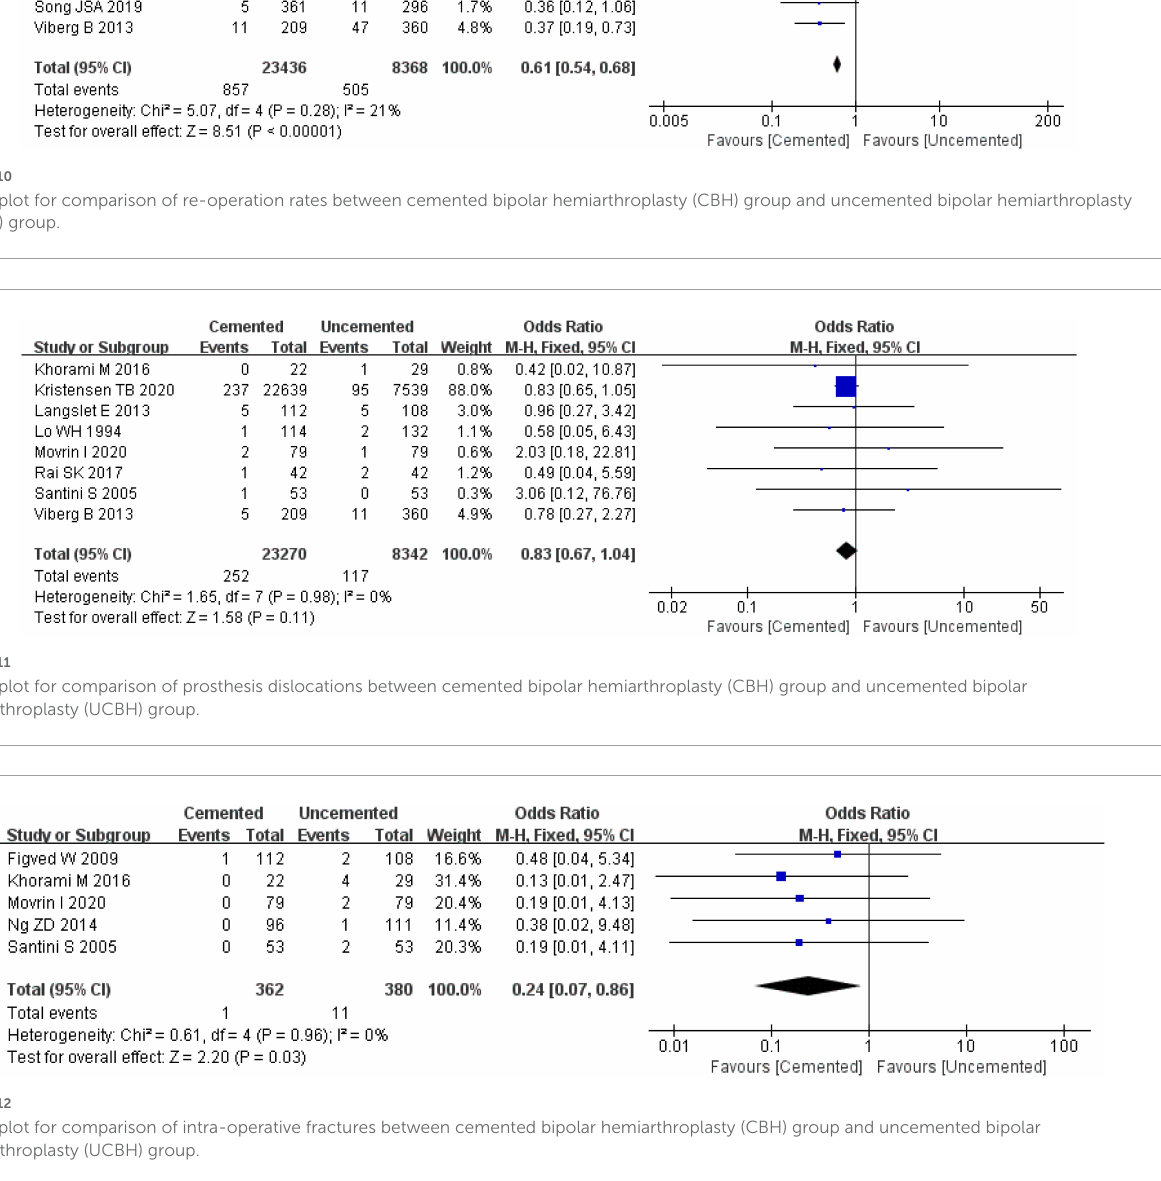
P = 0.65; I 2 = 0%, P = 0.65] between the two groups. The